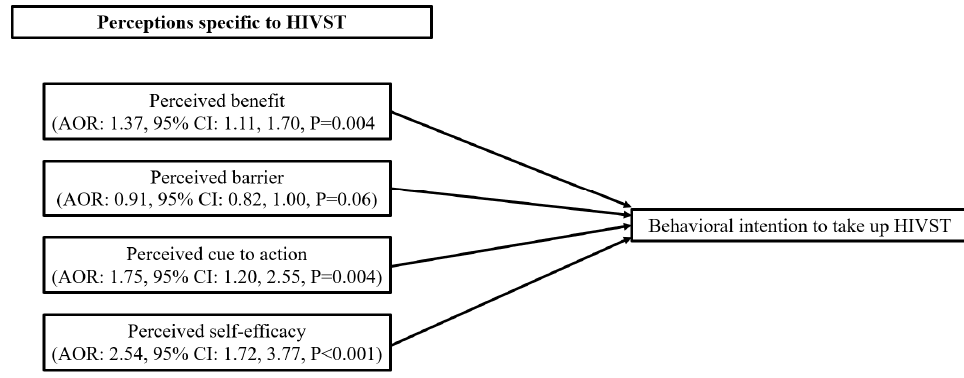
Figure 1. Factors associated with behavioral intention to take up any type of HIV testing.